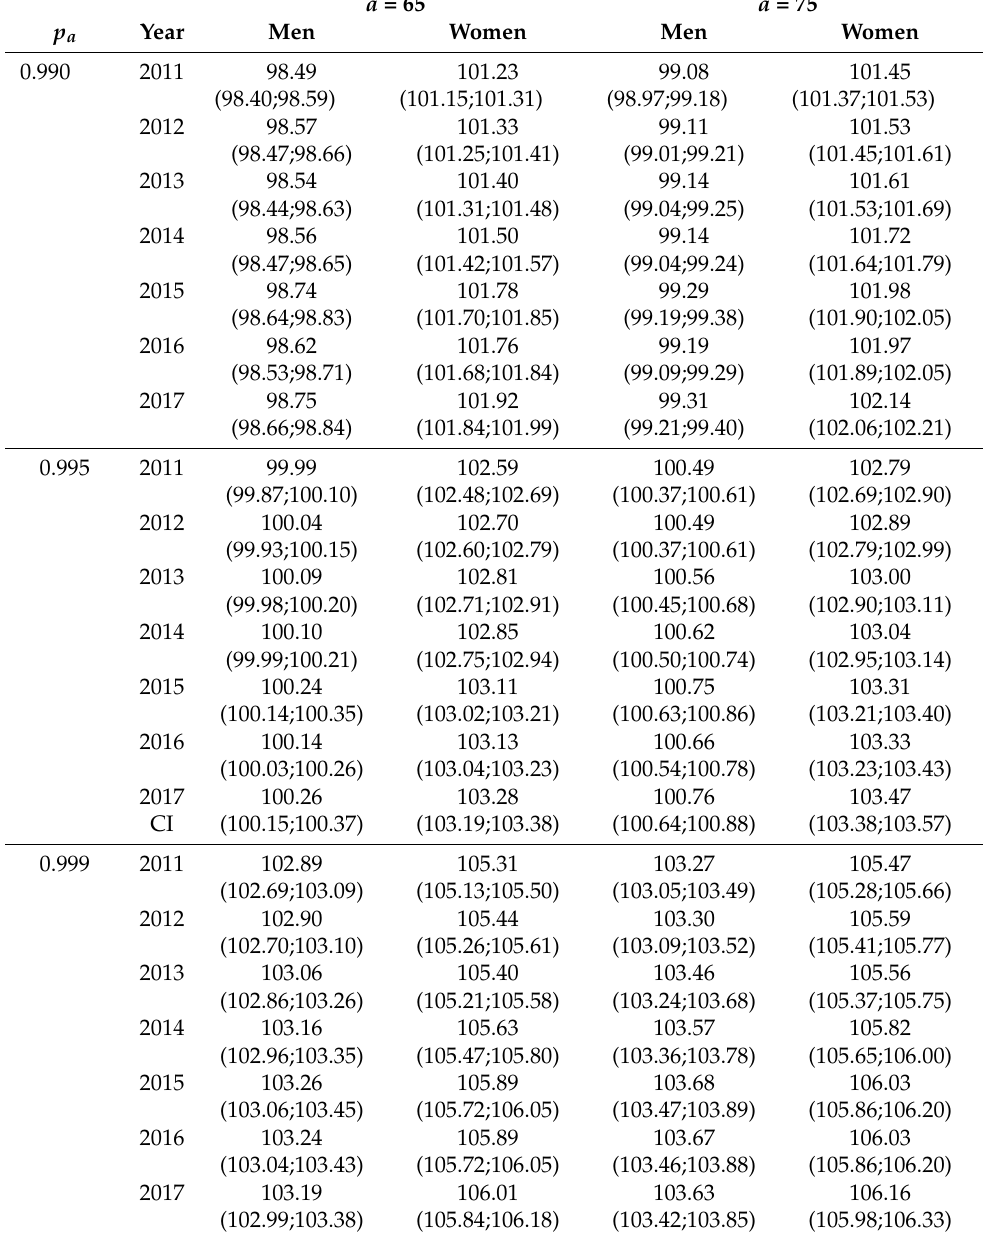
Table 2. Results of estimated CQ p and 90% confidence interval based on Beta Transformed Kernel a Estimator (BTKE) for the age-at-death of the population aged over 65 in Spain separately for men and women and conditional ages of the deceased population ( a = 65,75), from 2011 to